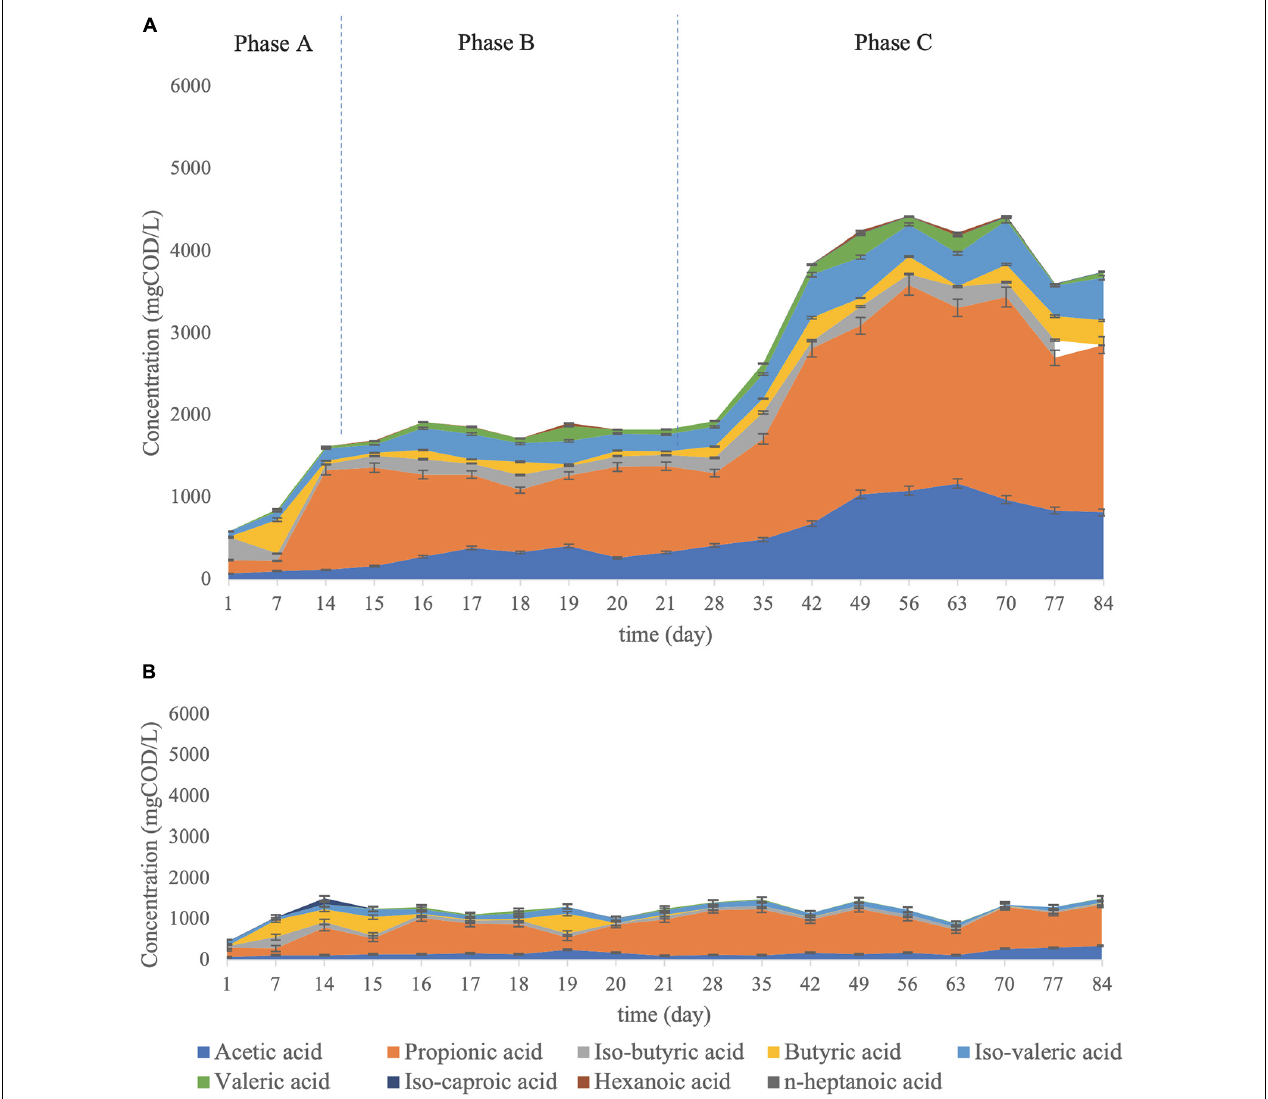
FIGURE 4 | VFA composition (A) in the C. aceticum bioaugmented reactor at Phase A: before bioaugmentation; Phase B: during bioaugmentation, and Phase C: after bioaugmentation and (B) in the control